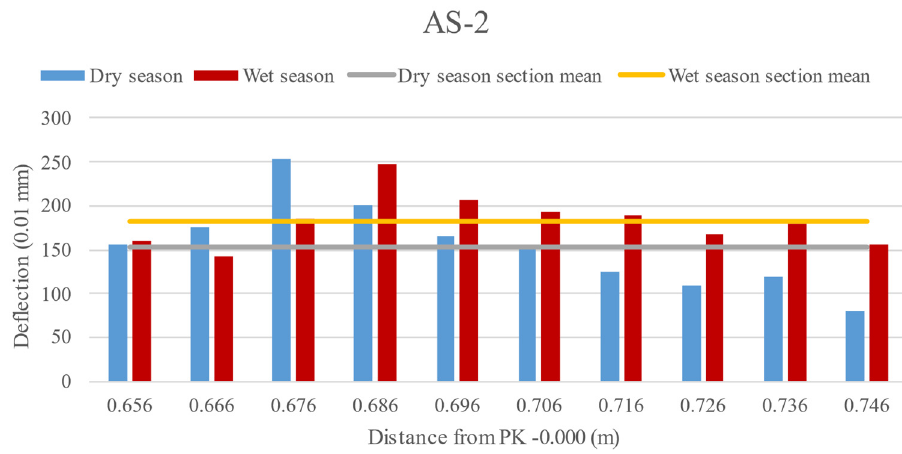
Figure 13. Deflection measurement in AS-2.